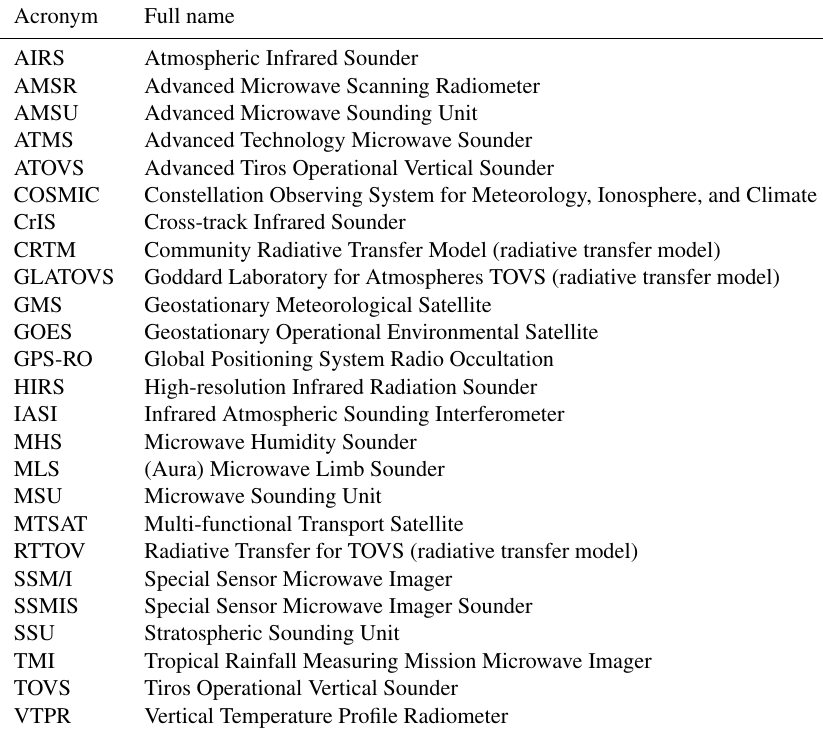
Table 1. List of acronyms for reanalysis assimilated observations and radiative transfer